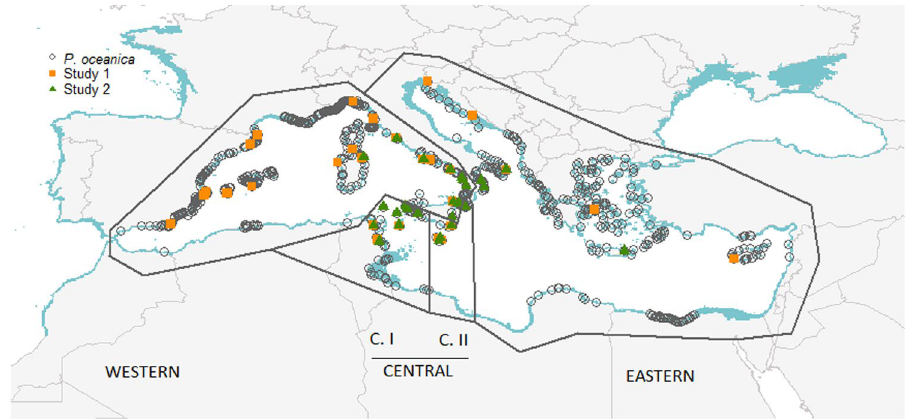
Figure 5. Occurrence data used for ecological niche models of Posidonia oceanica (grey circles), and genetic regions identified in the Mediterranean Sea by ref. 15 (Study 1): Western, Central and Eastern (populations in orange squares); and ref. 17 (Study 2): Western, Central I (C. I), Central II (C. II), and Eastern (populations in green triangles). The map was generated using R 43